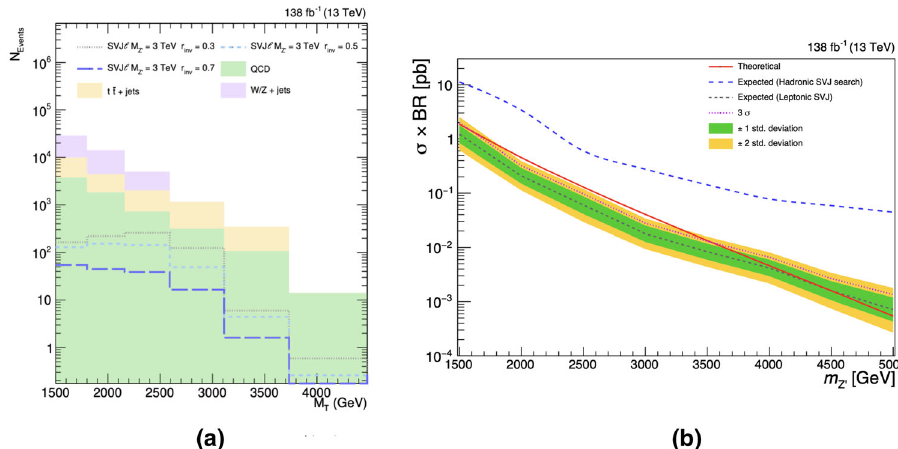
Fig. 3 a M T template for the signal (benchmark mass point M Z (cid:2) = 3 TeV and r inv = 0 . 3 , 0 . 5 , 0 . 7) and background processes after apply- ing the selections proposed in this Letter (without the requirement on m (cid:3)(cid:3) ). The binning has been chosen according to an experimental res- olution ∼ 20%. b Expected limits on σ × Br ( Z (cid:2) → q v ¯ q v ) for the